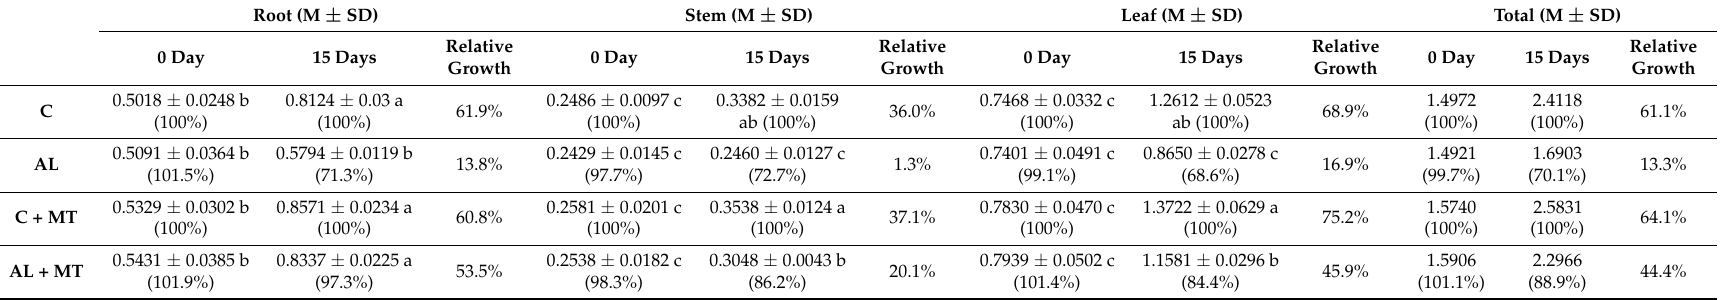
Table 2. Effects of 5 µ M melatonin treatment on tissue fresh weights (FW, g) measured from Malus hupehensis Rehd. seedlings under alkaline